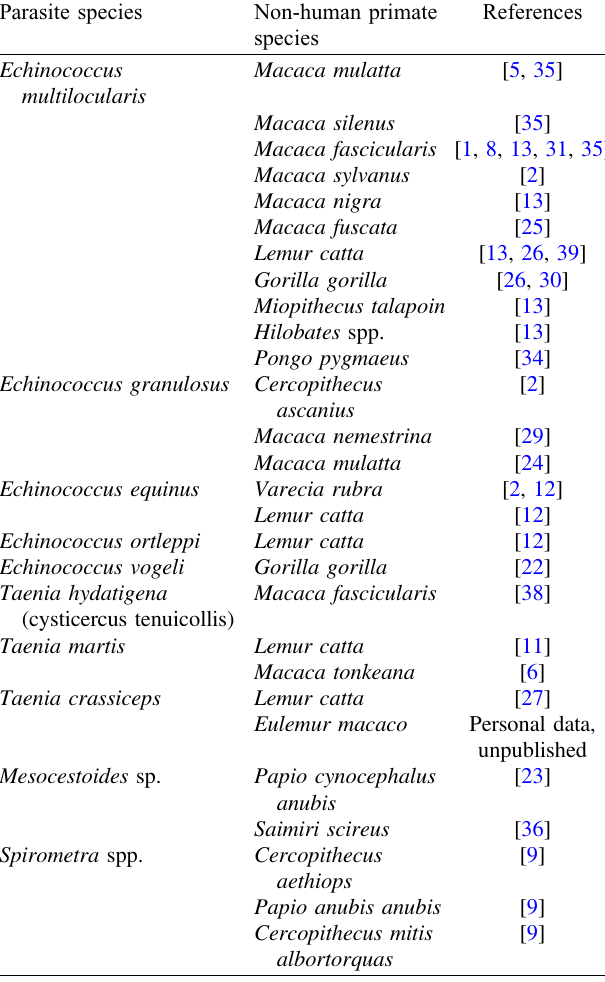
Table 3. Larval cestodiasis in NHPs reported in previous studies. Parasite